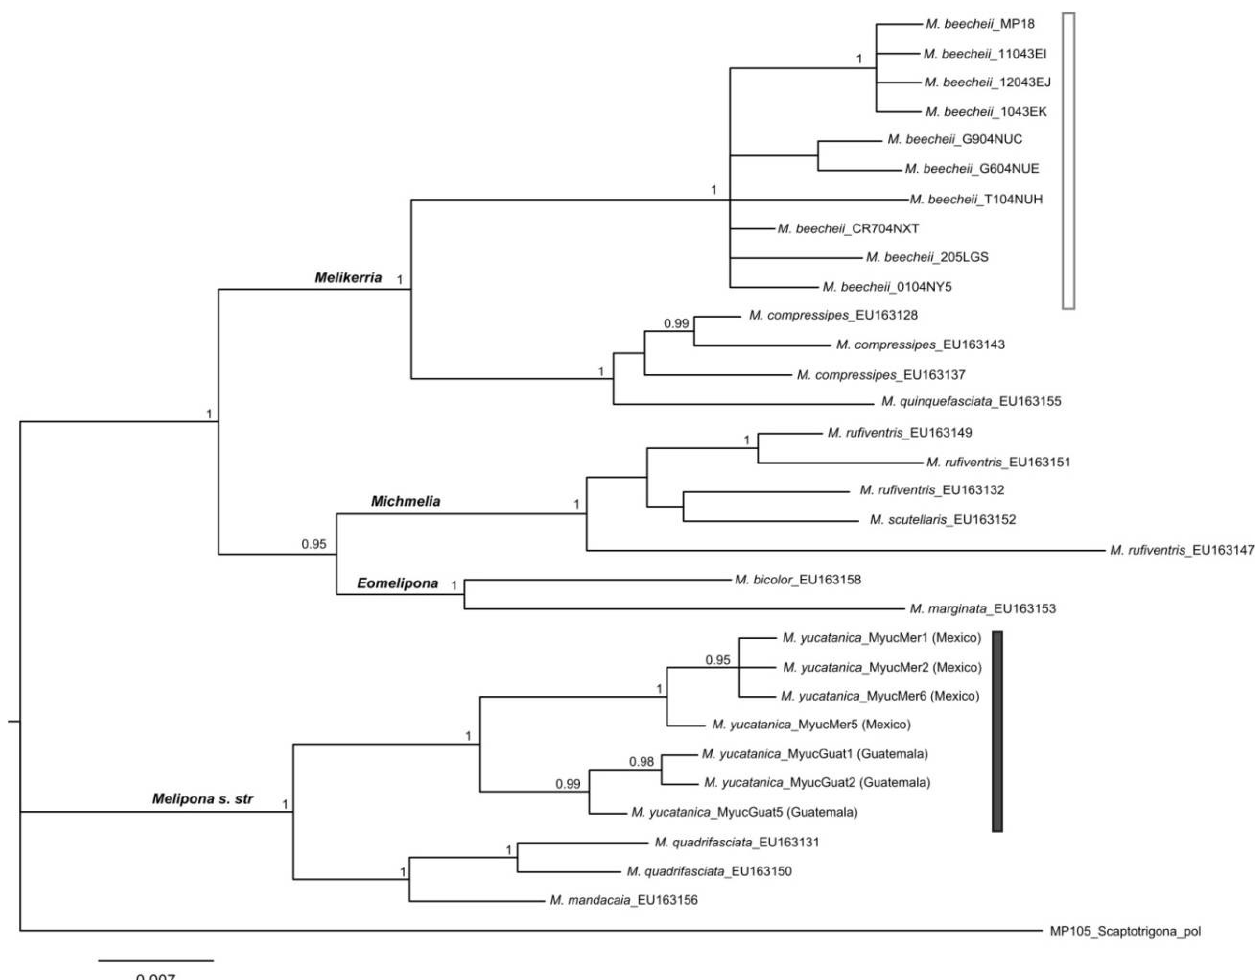
Fig 3 . Bayesian analysis of the available cox1 gene from Melipona species. Numbers above nodes show posterior probability ≥ 0.90. Population data of Melipona yucatanica are indicated with a solid bar. Available population data of several Melipona species are indicated with empty